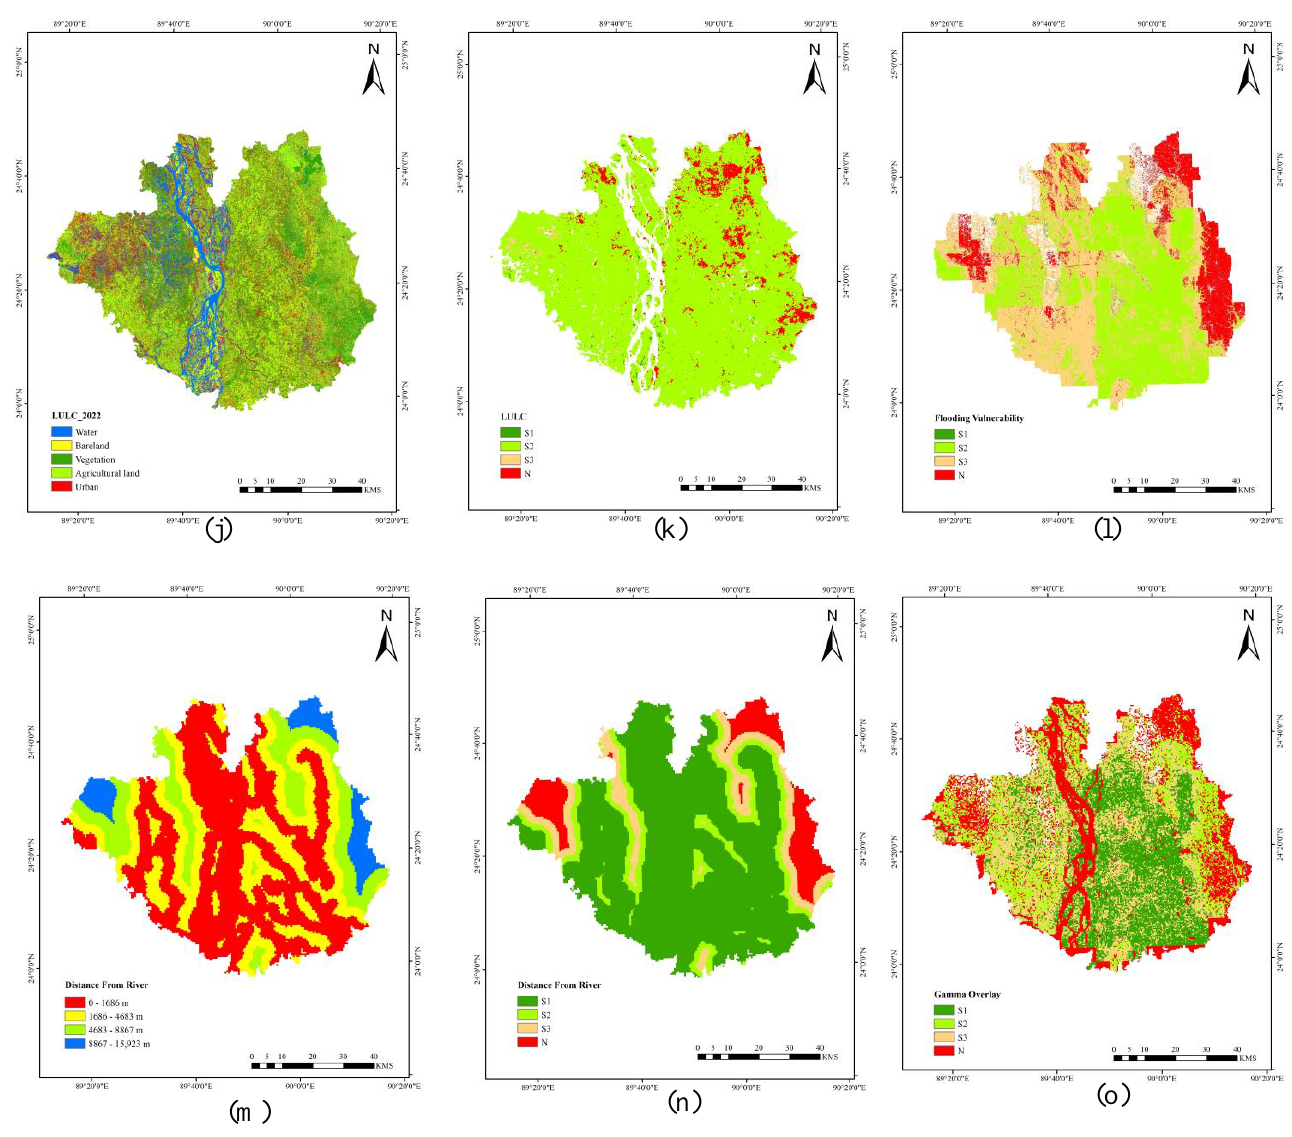
Figure 9. Reclassified suitability map of different indices for sugarcane and jute: ( a , b ) slope; ( c ) elevation; ( d , e ) soil pH; ( f , g ) soil texture; ( h , i ) rainfall; ( j , k ) LULC; ( l ) flooding vulnerability; ( m , n ) distance from river and ( o ) fuzzy gamma overlay, where S1, S2, S3 and N refer to high, moderate, marginal and suitable areas, respectively.